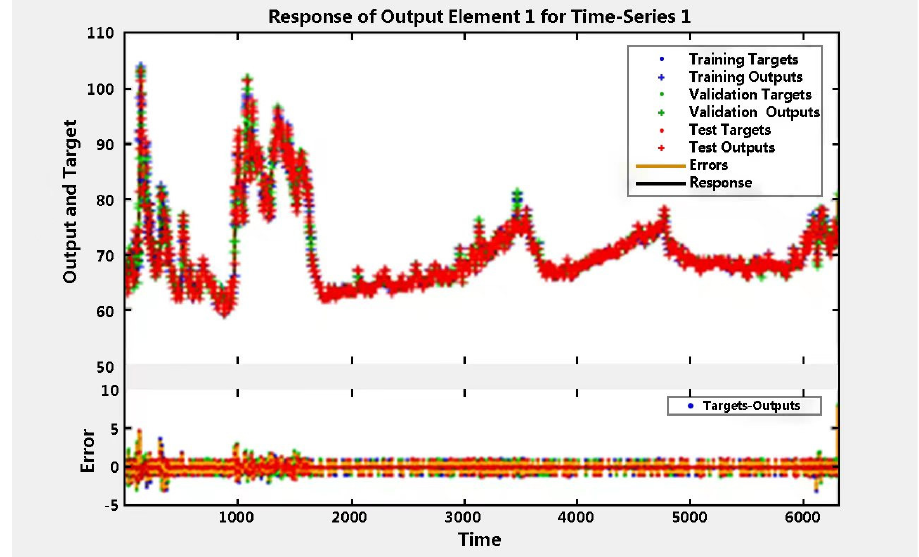
Figure 5. Output heart rate of time series response .